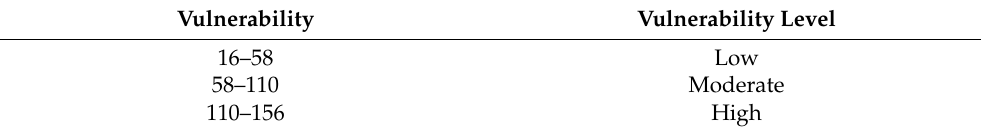
Table 3. Vulnerability classification.